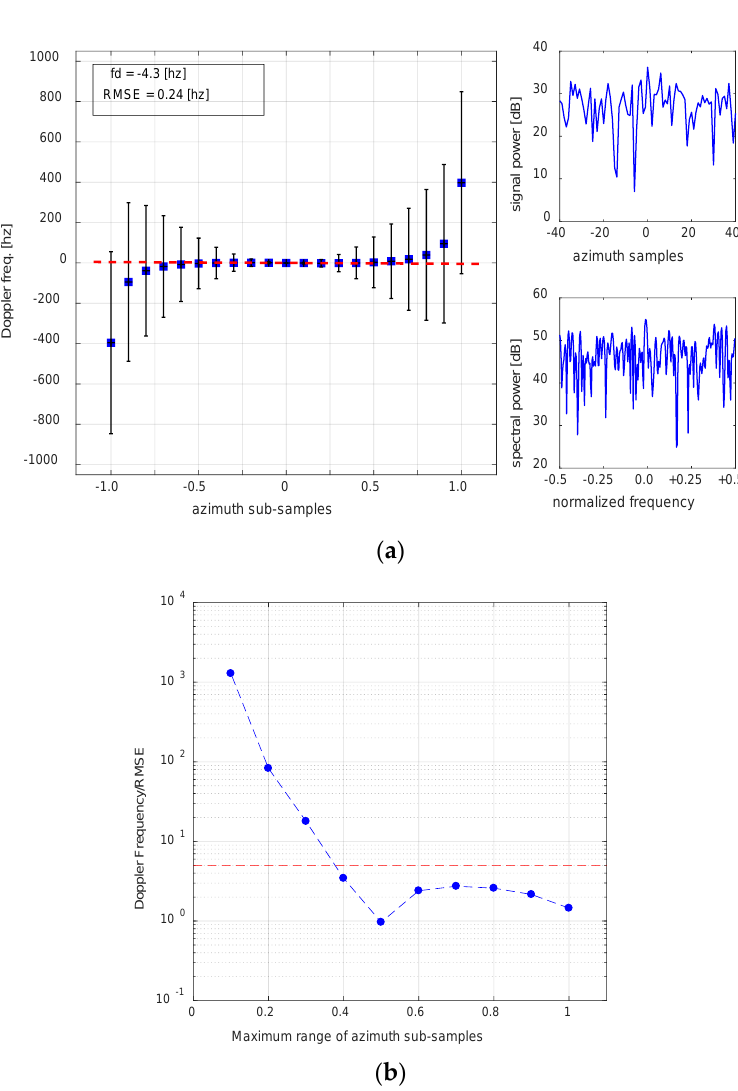
Figure 3. An application result for a weak stationary target, to determine an optimum ratio of Doppler frequency to RMSE for estimation on land. The PSLR of the target is − 4.3 dB, with an SCR of 9.6 dB. A ratio of larger than 5–10 would be acceptable for the on-land point targets.